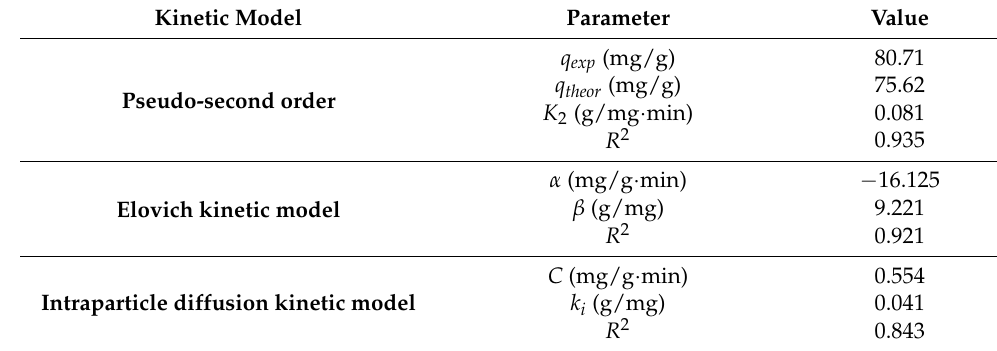
Table 2. Pseudo-first order, pseudo-second order, Elovich and intraparticle diffusion kinetic models for diazinon removal onto MIP-202/CA beads .